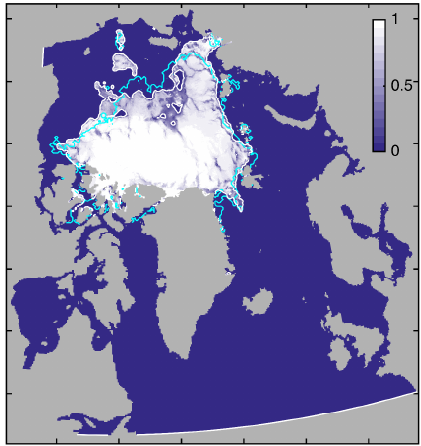
Figure 15. Modelled ice concentration at the observed extent mini- mum (19 September 2008). Overlaid are lines for the modelled and observed (AMSR-E) 15% concentration limit in white and cyan,